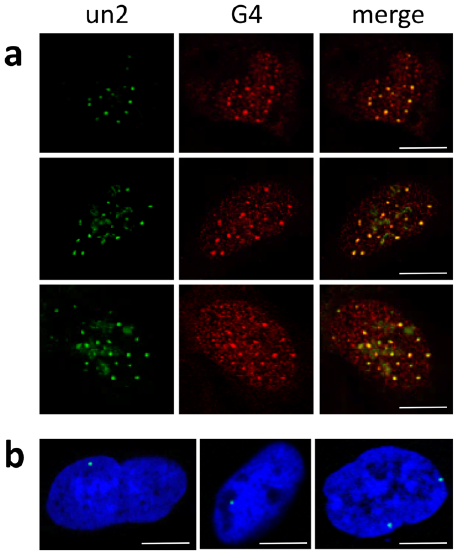
Fig. 2 ICP4 and un2 G4 colocalization in the nucleus of HSV-1 infected cells. a Representative images of immuno-DNA-FISH in U-2 OS cells infected with HSV-1, strain F, MOI of 3, fi xed at 8 hpi. The green and red signals correspond to un2 G4 and anti-G4 Ab signals, respectively; the merged signals are in yellow. Scale bars 10 µ m. Controls are shown in Supplementary Fig. S5; b Representative images of proximity ligation assay (PLA) in U-2 OS cells infected with HSV-1, strain F, MOI of 3, fi xed at 8 hpi. The green dots (PLA signal) correspond to G4-ICP4 interaction (one or two dots per nucleus). The blue signal corresponds to TOTO3 nuclear staining. Scale bars 10 µ m. Controls are shown in Supplementary Fig. S6. Both Immuno-DNA-FISH and PLA experiments were performed in three independent assays per tested